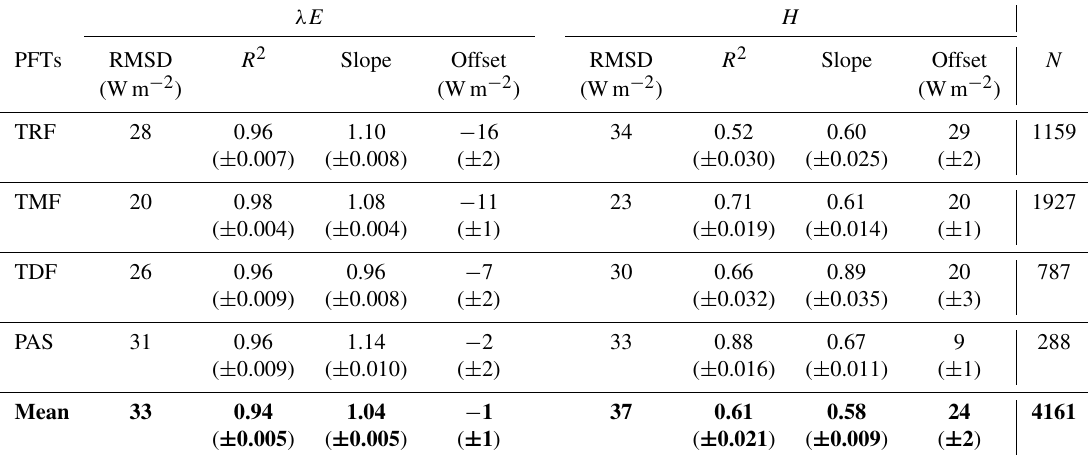
Table 4. Comparative statistics for the STIC- and tower-derived hourly λE and H for a range of PFTs in the Amazon Basin (LBA tower sites). Values in parentheses are ± 1 standard deviation (standard error for correlation).